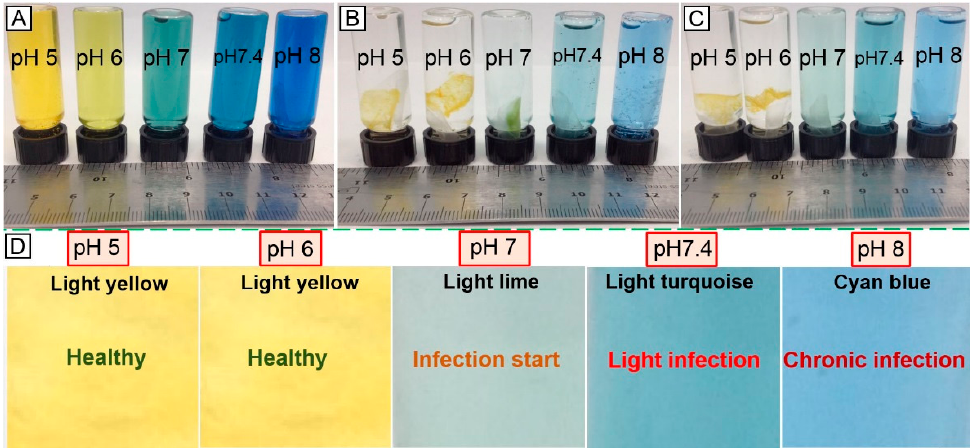
Figure 9. Visual infection responsivity of the two ‐ layer BTB ‐ loaded electrospun system. ( A ): Colouration of BTB solutions observed at varied pH. ( B , C ): Colour change capability of sample PAA * (PMMA ‐ co ‐ MAA)10 following contact with ( B ) and two ‐ hour incubation in ( C ) aqueous medium at varied pH. At basic pH, PMMA ‐ co ‐ MAA fibres becomes soluble in aqueous medium so that fibre ‐ loaded BTB is released, whilst inducing colour change. ( D ): Colour ‐ infection maps obtained via membrane incubation at varied pH.